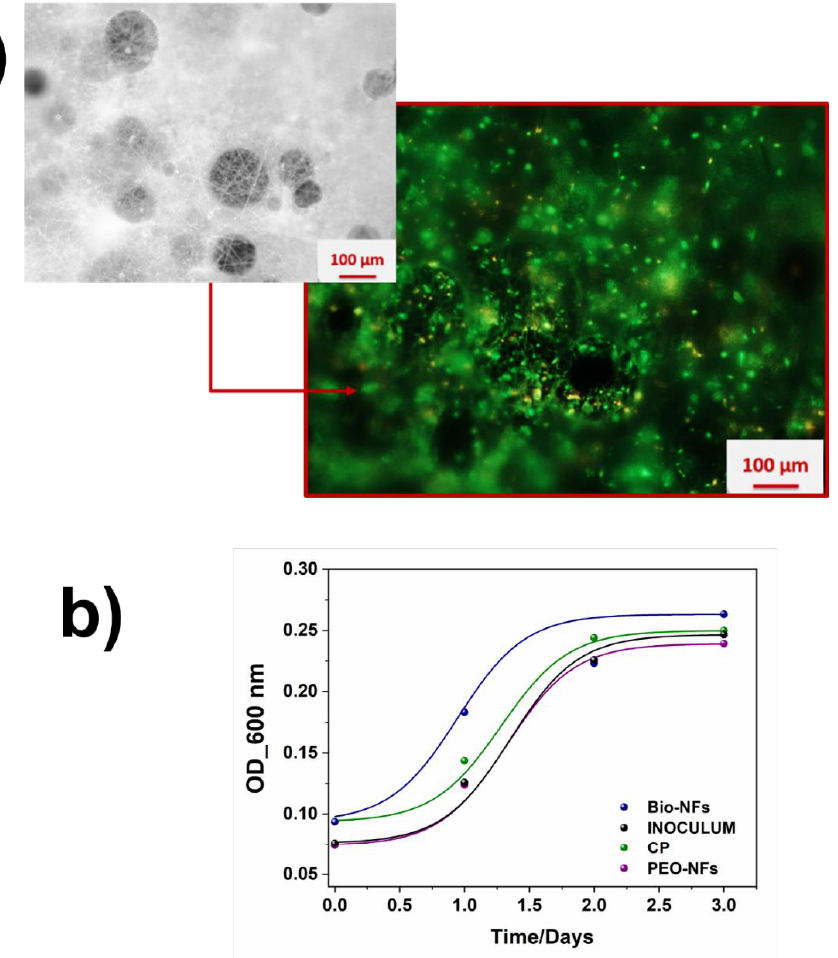
Figure 2. ( a ) Optical fluorescence characterizations of bio-NFs. In the red box, the presence of a certain amount of green spots confirmed the preservation of bacterial vitality after the electrospinning process; ( b ) Optical density (OD) measurement.